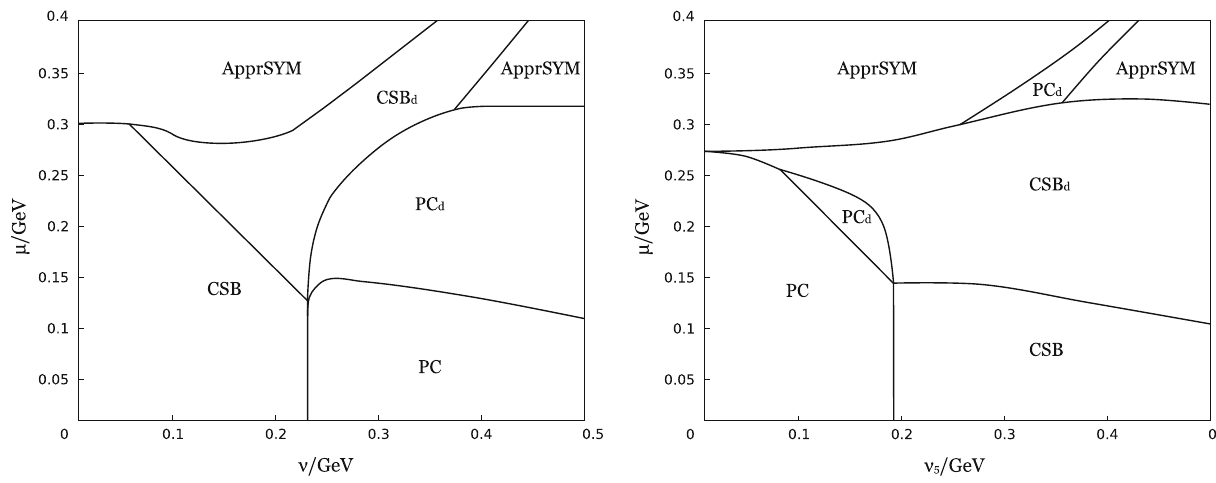
Fig. 6 The ( ν,μ )-phase portrait at ν 5 = 200MeV (left figure) and the ( ν 5 ,μ )-phase portrait at ν = 200MeV (right figure)